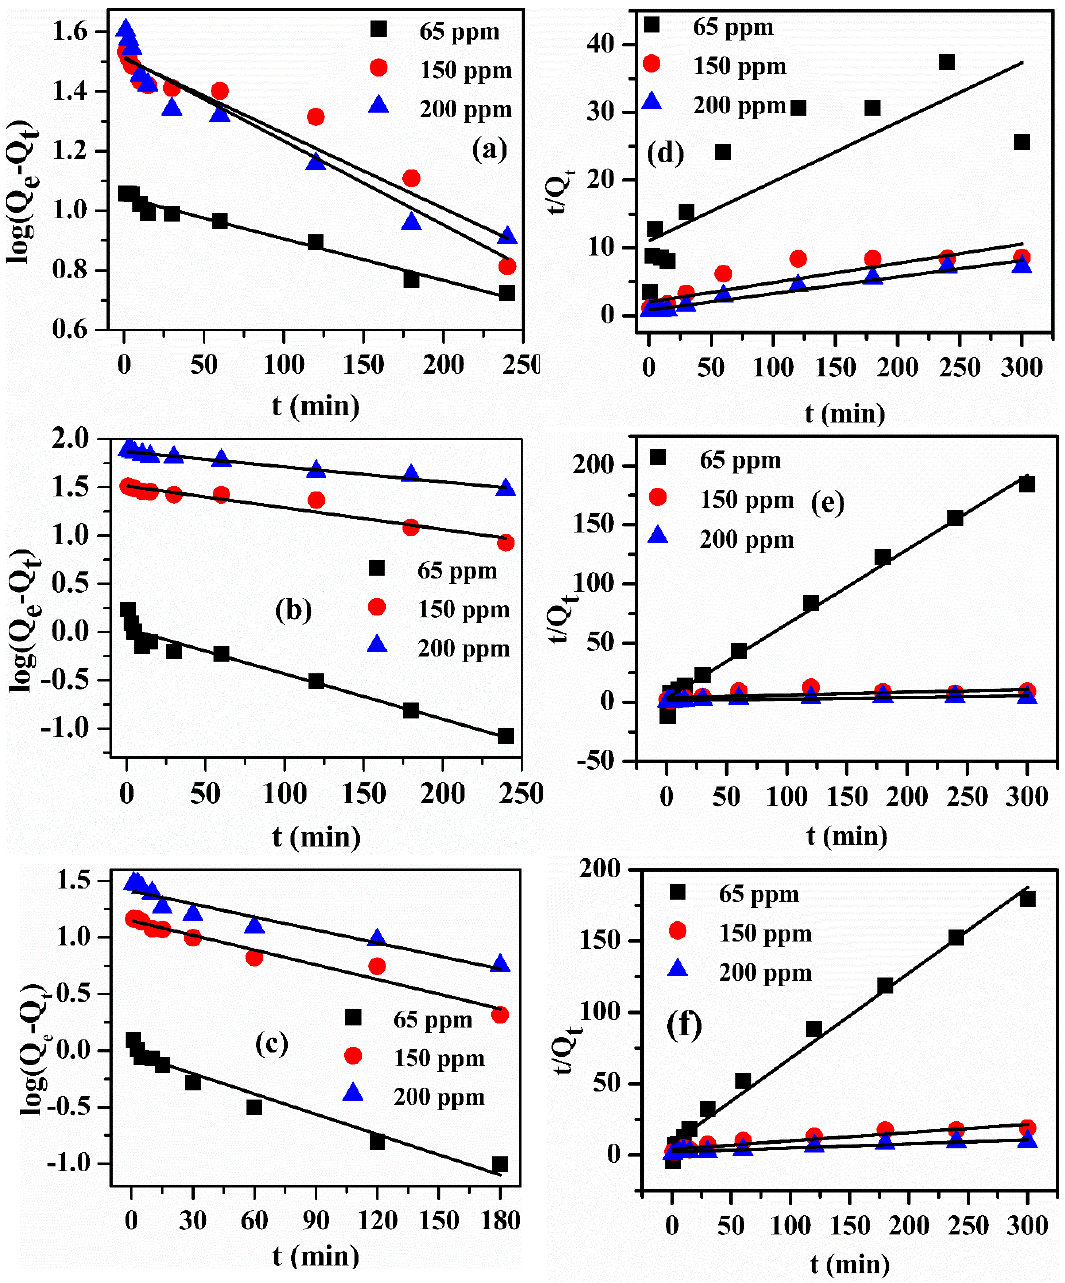
Figure 11. Pseudo-first-order kinetic model of Pb(II) onto the ( a ) PVA, ( b ) OPB / PVA and ( c ) OPB-PVA / MWCNTs while pseudo-second-order kinetic model of Pb(II) onto the ( d ) PVA, ( e ) OPB / PVA and ( f ) OPB-PVA / MWCNTs, respectively at various concentrations (65, 150 and 200 ppm). Experimental conditions: adsorbent dose = 0.5 g, pH = 7 and maximum adsorption time = 300 min (1, 3, 5, 10, 20, 30, 60, 120, 180, 240 and 300 min) at room temperature.